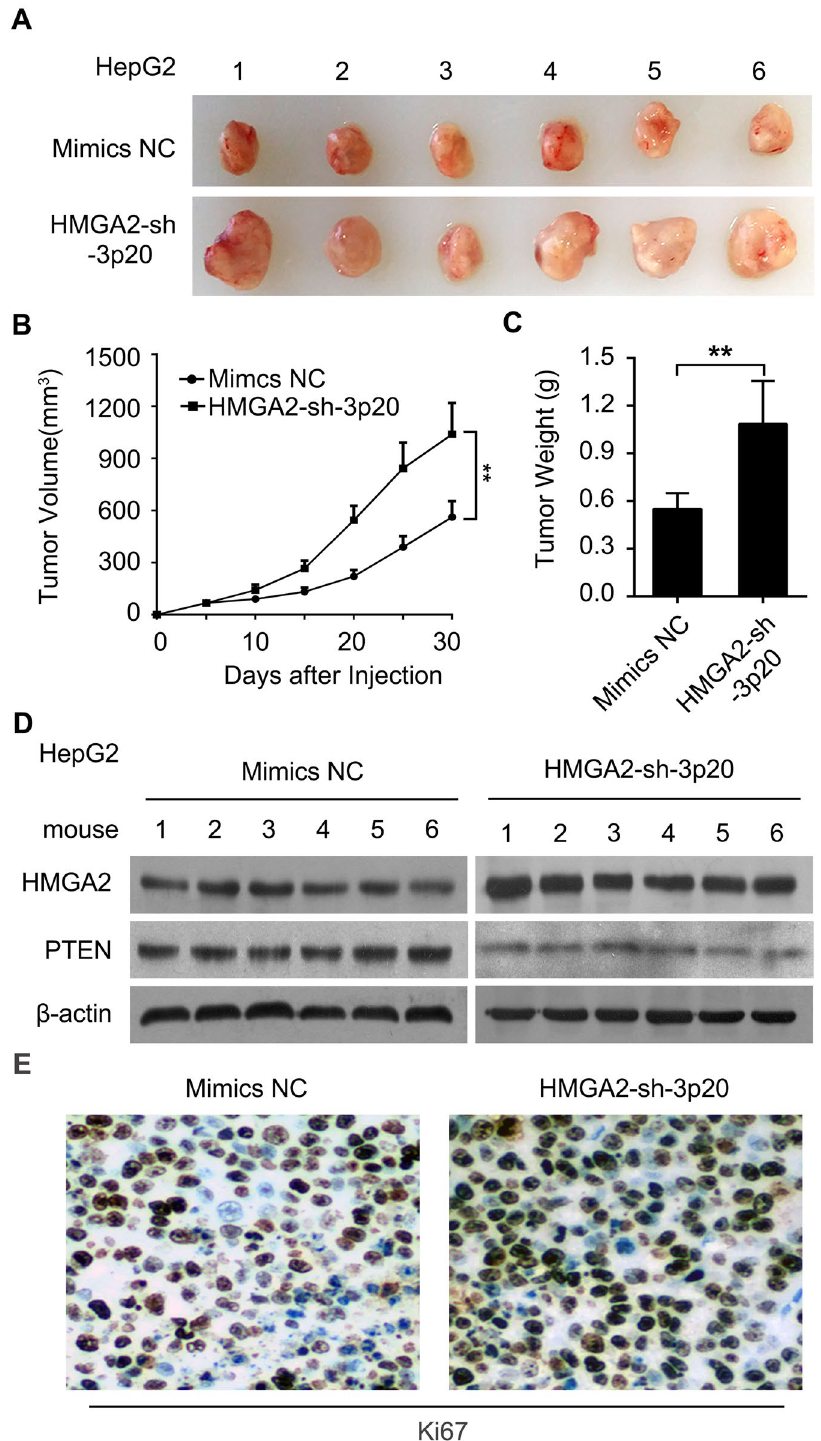
Figure 6. HMGA2-sh-3p20 contributes to the growth of hepatoma cells in vivo . ( A ) Photographs of dissected tumors from nude mice tumor transplanted with HepG2 cells pretreated with HMGA2-sh-3p20 or Mimics. ( B ) Growth curve of tumors from experimental groups of nude mice. ( C ) The average weight of tumors from experimental groups of nude mice. ( D ) Protein expression levels of HMGA2 and PTEN were examined by Western blot analysis in the tumor tissues from mice. ( E ) The expression levels of Ki67 were detected by IHC staining in the tumor tissues from